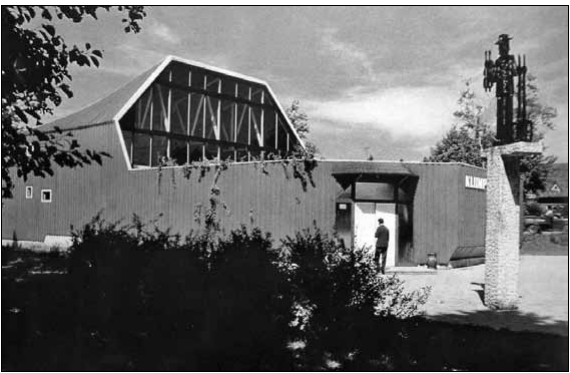
fig. 1. Pub Klumpė in Palanga, by architect Mikėnas, no longer in